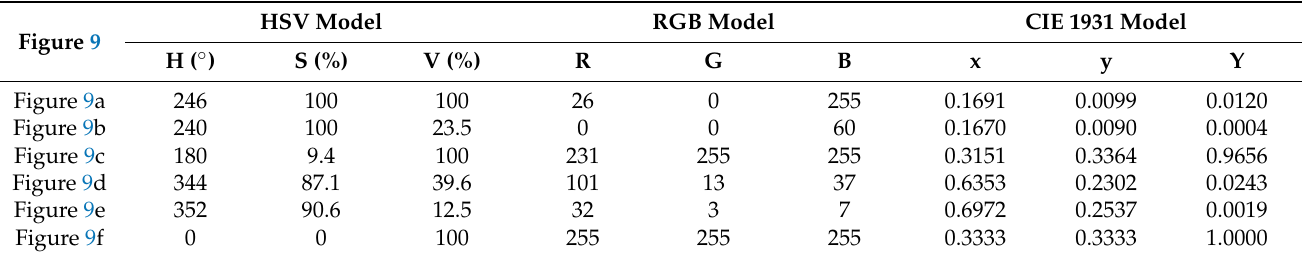
Table 1. Color space information based on camera exposure changes.